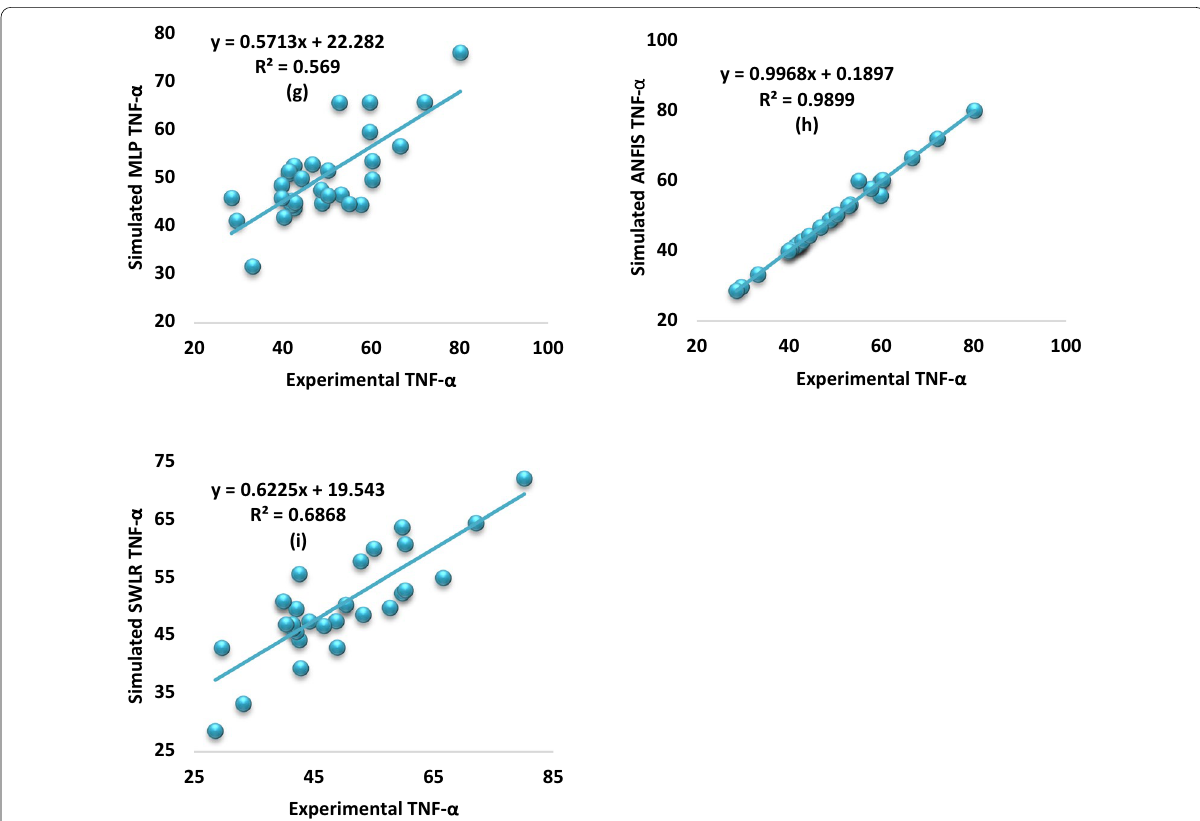
Fig. 5 Scatter plots for g MLP, h ANFIS and i SWLR